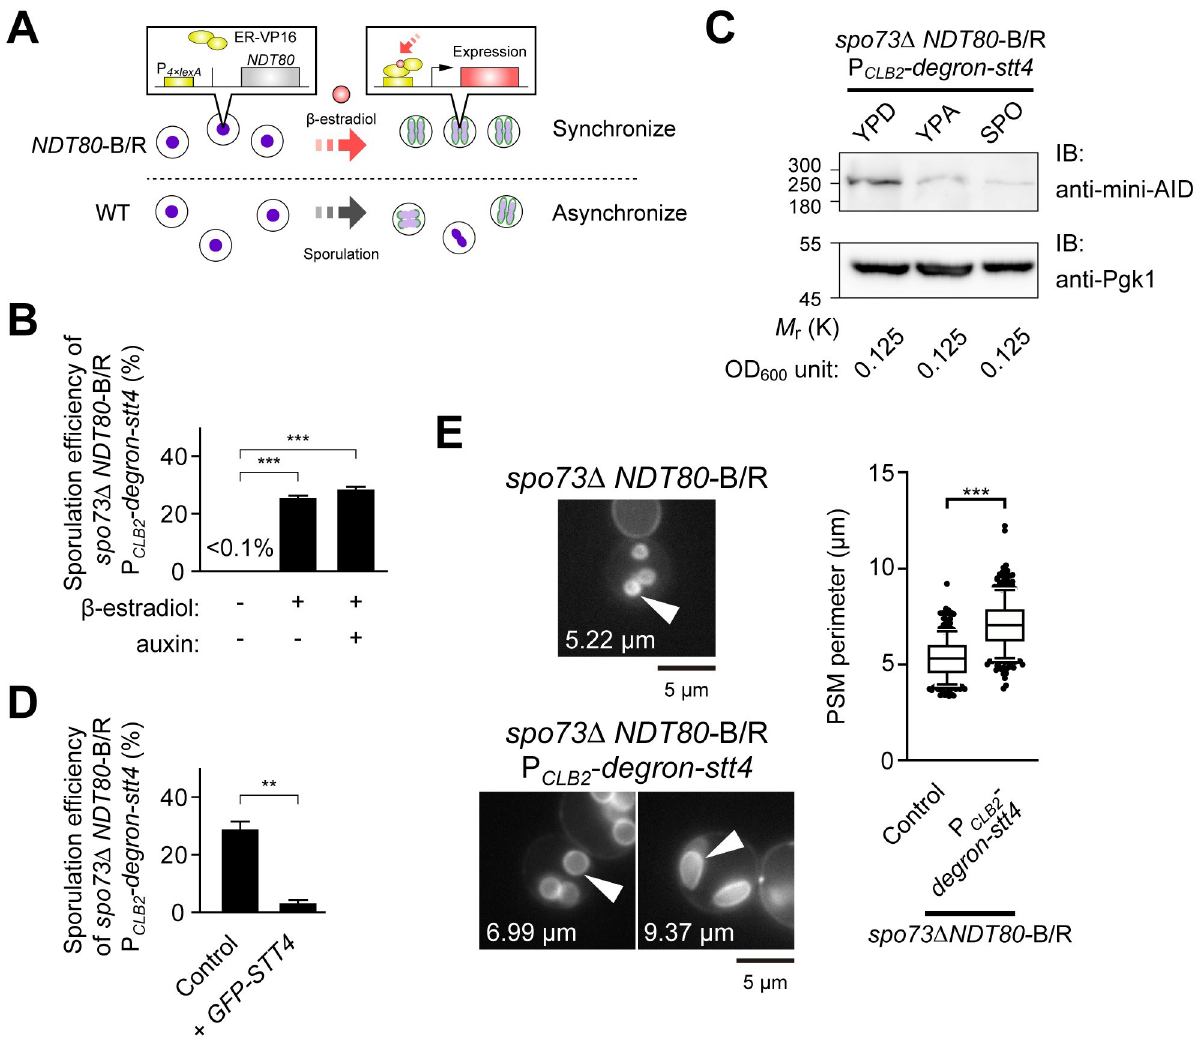
Fig 3. Sporulation-specific depletion of Stt4 suppresses the membrane extension defect of spo73 Δ . (A) Diagram of NDT80 block/release ( NDT80 - B/R) system. ER-VP16 is a chimeric protein of the bacterial DNA-binding protein LexA, the hormone-binding domain of the human estrogen receptor (ER) and fragment of the herpes simplex virus type 1 trans-activator VP16. When β -estradiol binds ER, ER-VP16 translocates into nucleus, binds P sequence, and induces expression of downstream coding sequence. (B) Assessment of sporulation in spo73 Δ NDT80 -B/R P 4×lexA stt4 (TNY502) with β -estradiol and auxin. More than 200 cells were observed in three independent colonies of each condition (for a total of > 600 cells). The bar graph shows the mean of the percentage of asci (N = 3). ��� , p < 0.001 (Tukey-Kramer test). (C) Assessment of protein level of degron- Stt4 in spo73 Δ NDT80 -B/R P CLB2 -degron-stt4 (TNY502) cells cultured in YPD, YPA, or SPO medium. The degron-Stt4 and Pgk1, as an internal control, were detected by anti-mini-AID and anti-Pgk1, respectively. Amounts of cells were adjusted to 0.125 OD 600 units. (D) Assessment of sporulation in spo73 Δ NDT80 -B/R P CLB2 -degron-stt4 expressing GFP-STT4 from P ADH1 (TNY517). TNY502 was assessed as a control strain. More than 200 cells were observed in three independent colonies of each condition (for a total of > 600 cells). The bar graph shows means of the percentage of asci (N = 3). �� , p < 0.01 (Student’s t test). (E) Left: Representative cells are shown. The perimeter of the PSM indicated by white arrow heads are shown. Right: Assessment of the perimeter of the PSM in spo73 Δ NDT80 -B/R producing mKate2-Spo20 51–91 (TNY198) or spo73 Δ NDT80 -B/R P CLB2 - degron-stt4 producing mKate2-Spo20 51–91 (TNY518) cells. More than 50 PSMs were measured in three independent colonies of each strain (for a total of 250 or 303 PSMs, respectively). The whiskers indicate the 10th and 90th percentiles and dots indicate outliers. ��� , p < 0.001 (Student’s t test). mK, mKate2. Scale bar, 5 μ